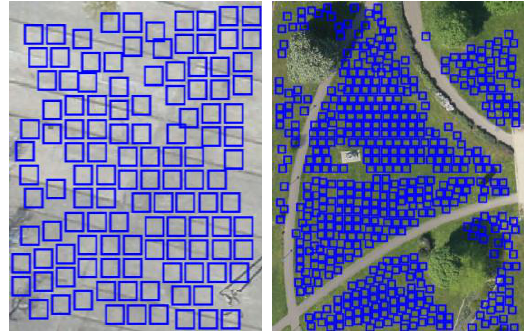
Figure 2. Selected patches on the paved ground (left, 112 patches) and grassland (right, 527 patches) for evaluating the filtering performance. The patch sizes are 2 m × 2 m.